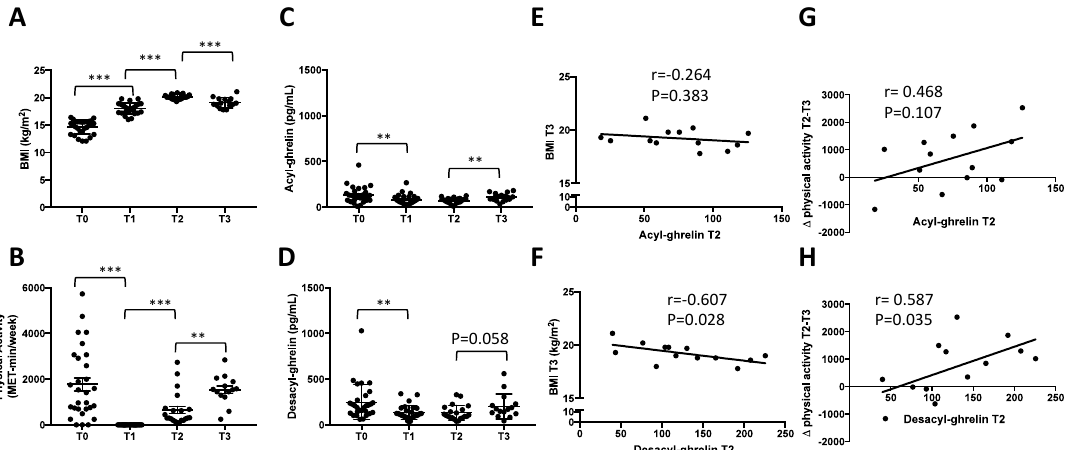
Figure 1. Longitudinal evolution of acyl-ghrelin (AG) and desacyl-ghrelin (DAG) during inpatient weight restoration and one-month post discharge. One-month post hospitalisation (T3), BMI ( A ) and physical activity ( B ) significantly decreased and plasma concentrations of AG ( C ) increased but not DAG ( D ). Plasma concentrations of DAG at the end of hospitalisation (T2) were negatively correlated to BMI one month later (T3, F ), but not AG ( E ) and positively correlated to the increase of physical activity between the end of hospitalisation and one month later ( H ), but not AG ( G ). Only statistical di ff erences between two consecutive time-points are reported. T0 = 1-week post-admission; T1 = 50–70% of target BMI reached; T2 = discharge BMI (close to target BMI); T3 = 1-month post-discharge visit. BMI: body mass index. MET: metabolic equivalent of task. ** p < 0.01; *** p <